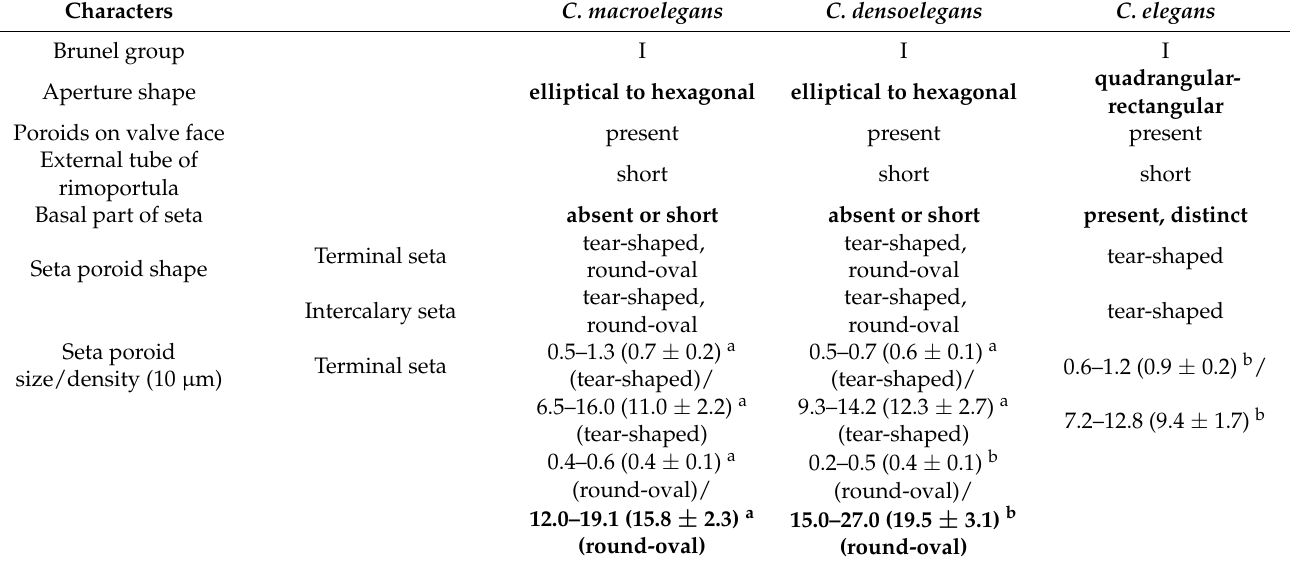
Table 2. Morphological comparison among C. elegans , C. macroelegans sp. nov. and C. densoelegans sp. nov. a,b indicates statistically significant difference ( p < 0.01). The most important morphological differences are highlighted in